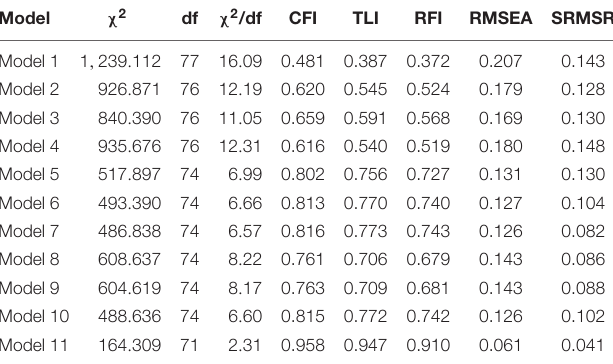
TABLE 3 | Confirmatory factor analysis results of measurement model.